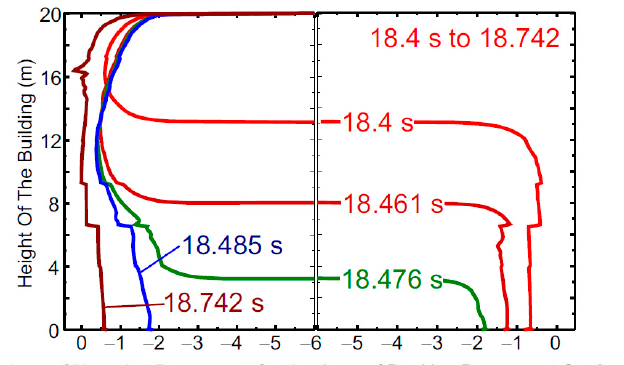
Figure 16. Permanent strains in the building model after the fifth pulse, during the short time interval from 18.4 s to 18.742 s. The evolution of permanent strains during the time just preceding the collapse of the building, is shown, which occurs after 18.742